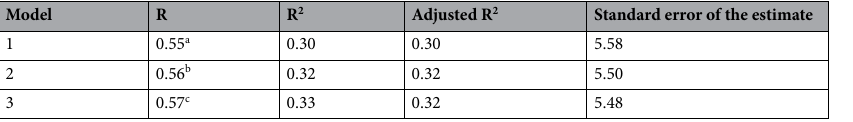
Table 4. PHQ-9 regression model summary. a Predictors: (constant), Pre-PHQ-9 sum. b Predictors: (constant), Pre-PHQ-9 sum, age × gender. c Predictors: (constant), Pre-PHQ-9 sum, age × gender, gender ×